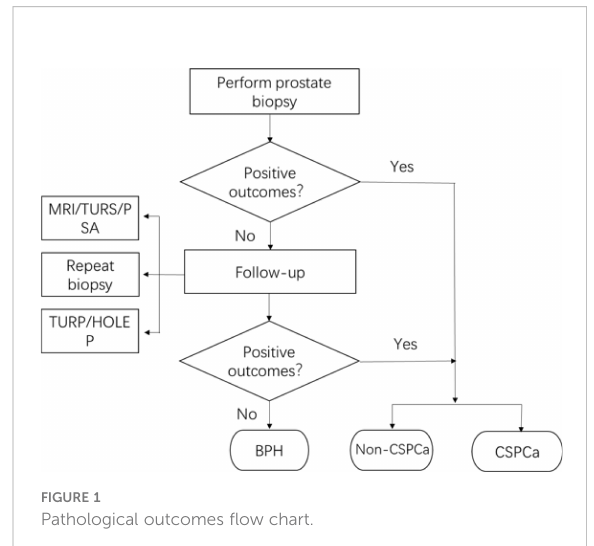
FIGURE 1 Pathological outcomes fl ow chart.